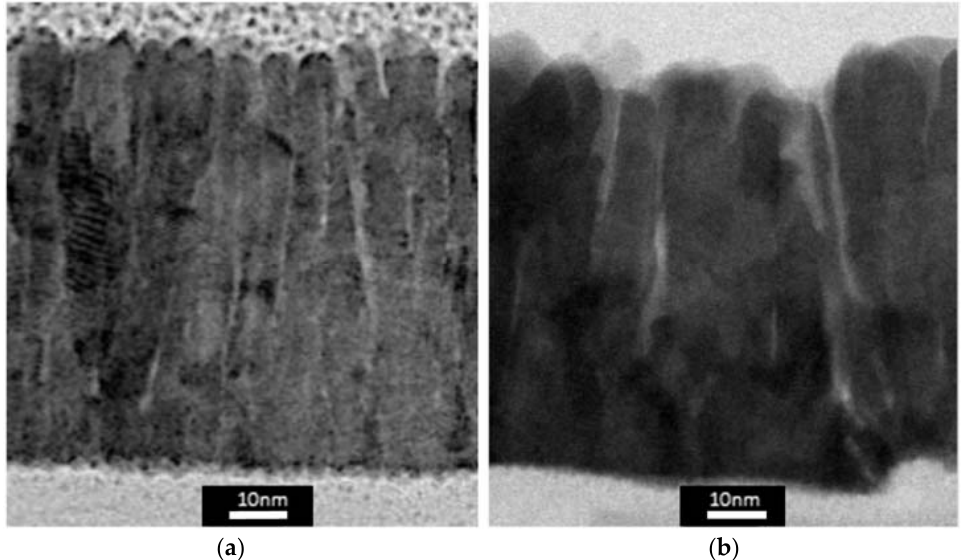
Figure 4. STEM image of the samples produced by Pt ‐ C and Pt targets sputtering using pulsed magnetron sputtering regime (frequency 100 kHz). ( a ) Pt ‐ C film deposited on Ti substrate. ( b ) Pt film deposited on Ti substrate. Scale bar 10 nm.